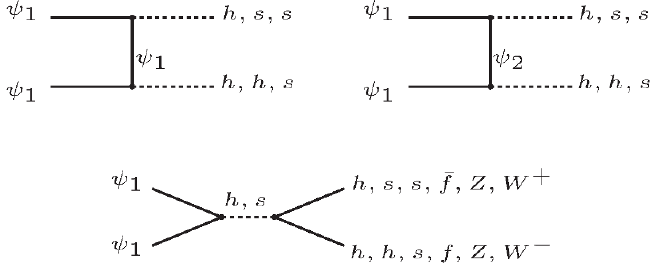
Figure 2 . Feynman diagrams for the DM annihilation processes are shown. Only diagrams with two particles in the (cid:12)nal state are given